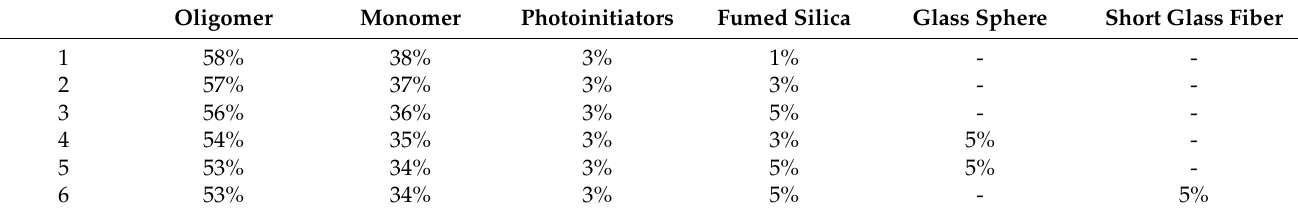
Table 3. The composition of the test material (weight percentage).